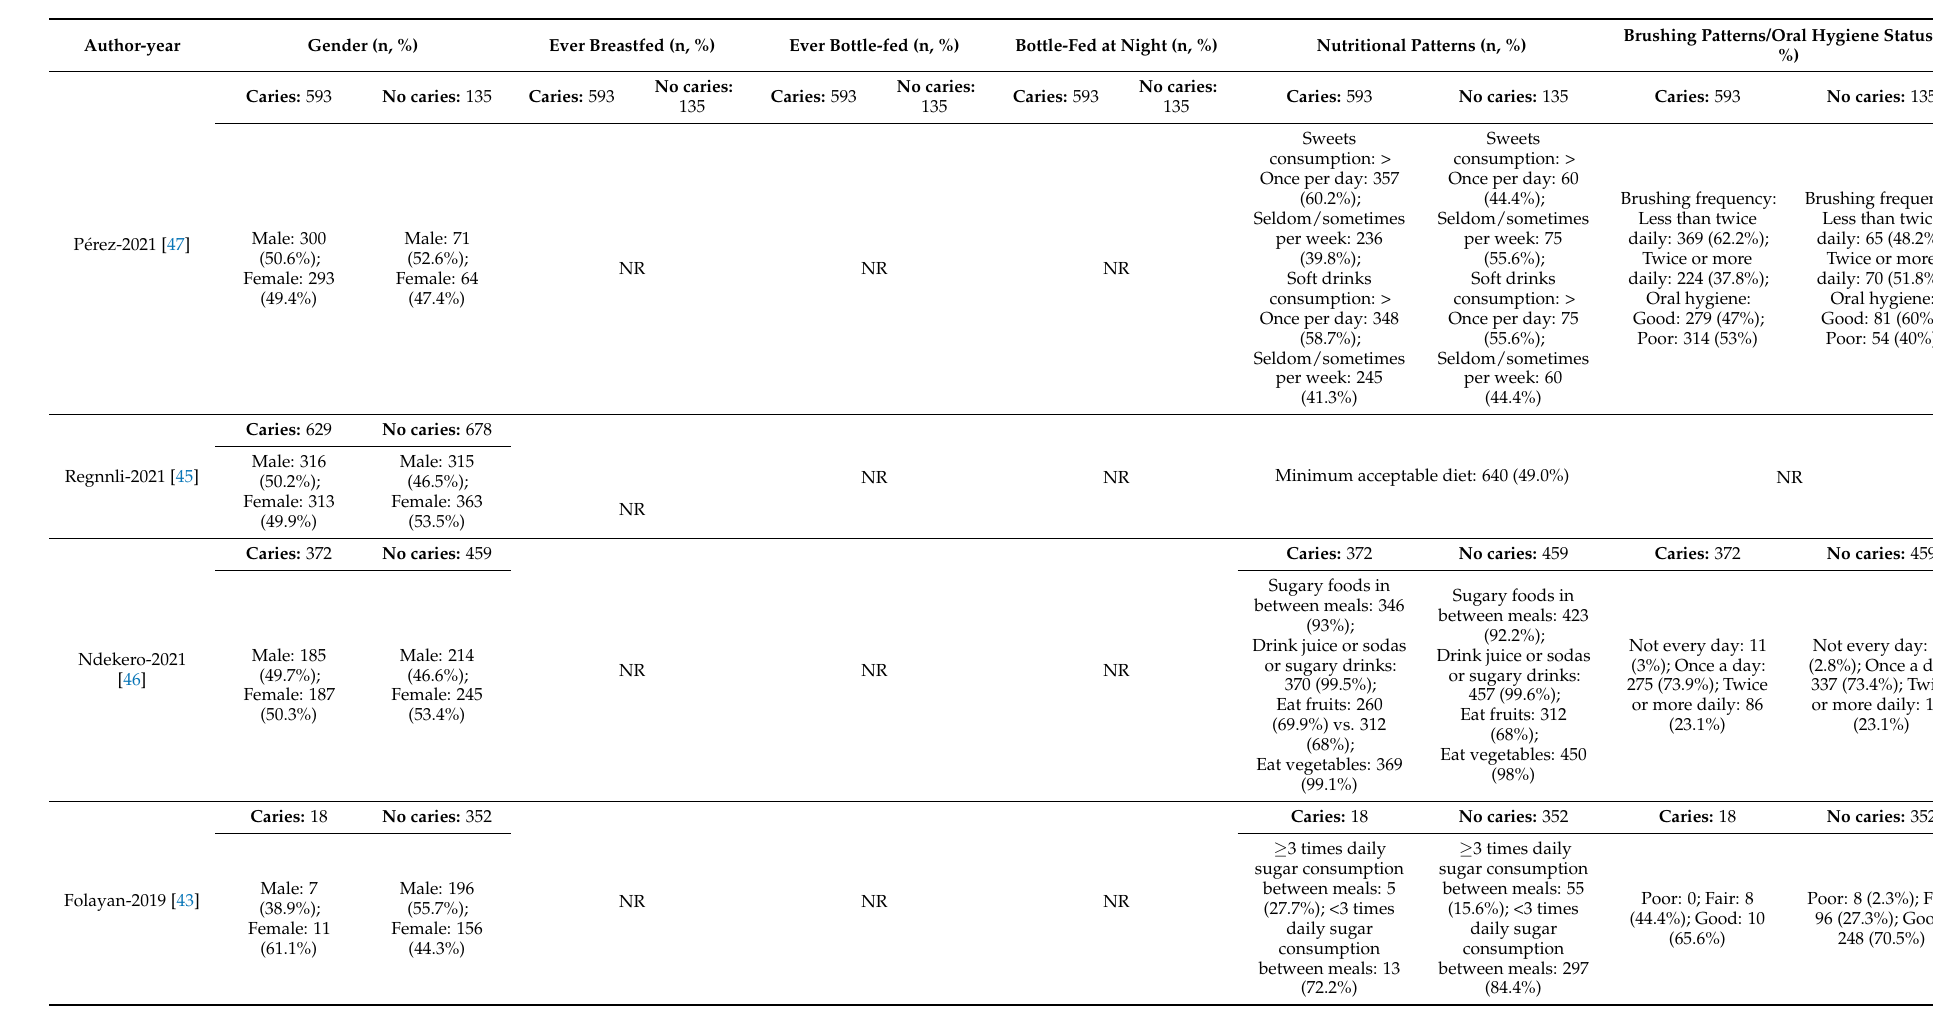
Table 2. Child-level characteristics of eleven